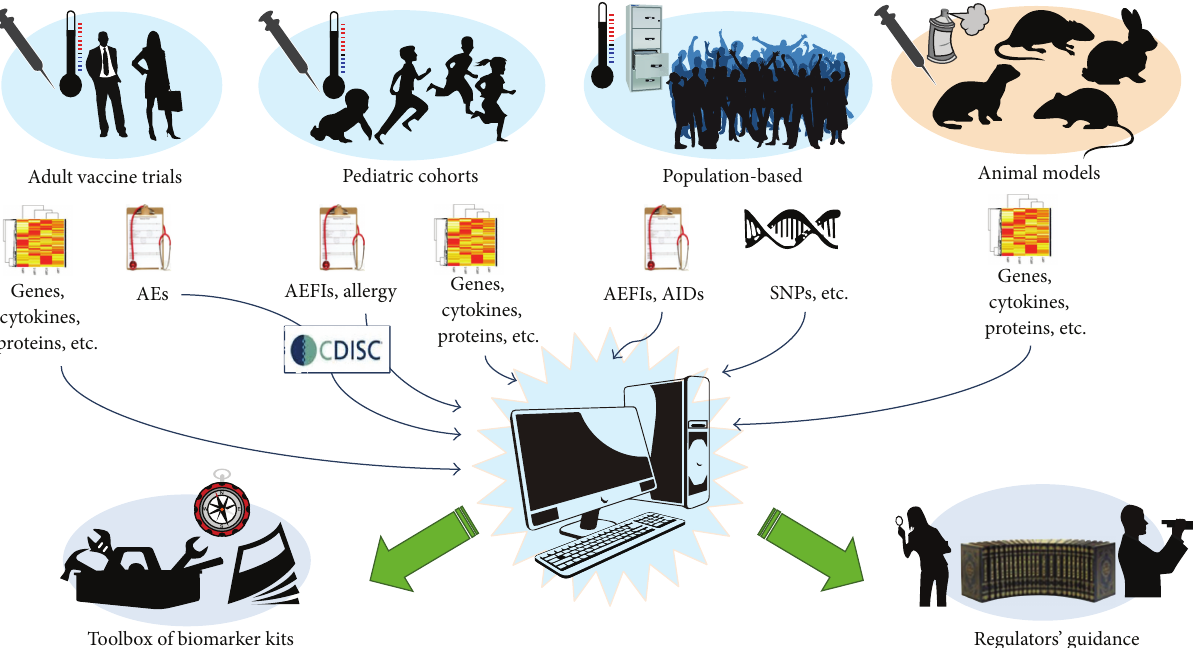
Figure 1: Integration of multiparametric “omics” data with clinical events from human clinical trials, together with population genetics, pediatric cohorts, and animal models in the BIOVACSAFE project.